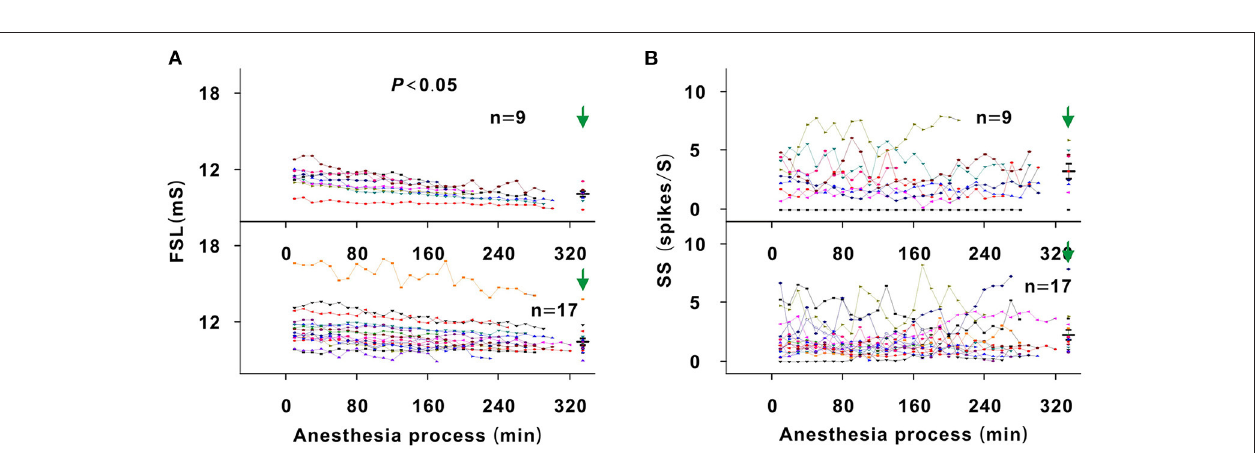
FIGURE 7 | changes with anesthesia time (red curve and left ordinate for the CF, blue curve and right ordinate for the BW 20 dB SPL above MT ); hereafter, the CF- and BW 20 dB SPL above MT -time curves. (C) ES 20 dB SPL above MT changes with anesthesia time; hereafter, the ES 20 dB SPL above MT -time curves. (D) Summary of the CF-time curves in neurons changed MT (upper curves) and neurons unchanged MT (lower curves) [Upper curves: first four recording sessions vs. middle four recording sessions vs. last four recording sessions vs. pre-anesthesia awake state (20.957 ± 6.791) vs. (21.682 ± 5.407) vs. (21.415 ± 6.525) vs. (21.072 ± 6.462) kHz, F = 0.025, P = 0.995, one-way ANOVA; Lower curves: first four recording sessions vs. middle four recording sessions vs. last four recording sessions vs. pre-anesthesia awake state (17.795 ± 9.182) vs. (19.036 ± 9.640) vs. (19.396 ± 10.212) vs. (21.001 ± 11.621) kHz, F = 0.285, P = 0.836, one-way ANOVA]. (E) Summary of the BW 20 dB SPL above MT -time curves in neurons changed MT (upper curves) and neurons unchanged MT (lower curves) [Upper curves: first four recording sessions vs. middle four recording sessions vs. last four recording sessions vs. pre-anesthesia awake state (0.919 ± 0.130) vs. (0.856 ± 0.221) vs. (0.894 ± 0.181) vs. (0.900 ± 0.224) Oct., F = 1.174, P = 0.913, one-way ANOVA; Lower curves: first four recording sessions vs. middle four recording sessions vs. last four recording sessions vs. pre-anesthesia awake state (1.037 ± 0.354) vs. (0.954 ± 0.357) vs. (0.912 ± 0.336) vs. (0.953 ± 0.310) Oct., F = 0.404, P = 0.751, one-way ANOVA]. (F) Summary of the ES 20 dB SPL above MT -time curves in neurons changed MT (upper curves) and neurons unchanged MT (lower curves) [Upper curves: first four recording sessions vs. middle four recording sessions vs. last four recording sessions vs. pre-anesthesia awake state (9.637 ± 3.851) vs. (6.084 ± 2.734) vs. (5.030 ± 2.934) vs. (5.101 ± 2.325) spikes/Sti., F = 4.668, P = 0.008, one-way ANOVA, Multiple comparisons (LSD): P = 0.003 for first four recording sessions vs. last four recording sessions, P = 0.003 for first four recording sessions vs. pre-anesthesia awake state; Lower curves: first four recording sessions vs. middle four recording sessions vs. last four recording sessions vs. pre-anesthesia awake state (4.584 ± 2.277) vs. (3.005 ± 1.525) vs. (2.280 ± 1.357) vs. (2.484 ± 1.203) spikes/Sti., F = 6.849, P = 4.493 × 10 − 4 , one-way ANOVA, Multiple comparisons (Tamhane’s T2): P = 0.008 for first four recording sessions vs. last four recording sessions, P = 0.015 for first four recording sessions vs. pre-anesthesia awake state]. (G) Scatterplot for the slopes of the ES 20 dB SPL above MT -time curves against the MT pre − anesthesia awake and the fitting curve to a linear equation ( P = 0.043, R 2 = 0.081, intercept = − 0.031, slope = − 0.003).